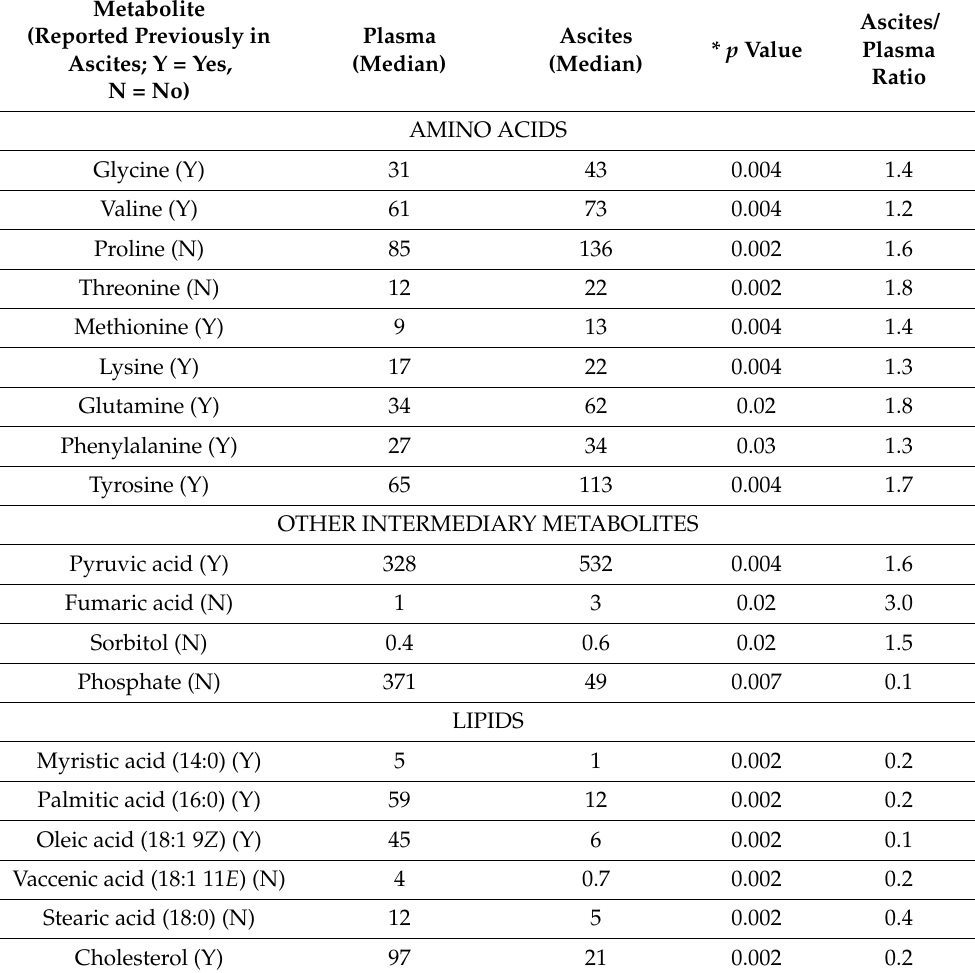
Table 2. Metabolites showing a difference in ascites and plasma relative concentration. Metabolite (Reported Previously in Ascites; Y = Yes,